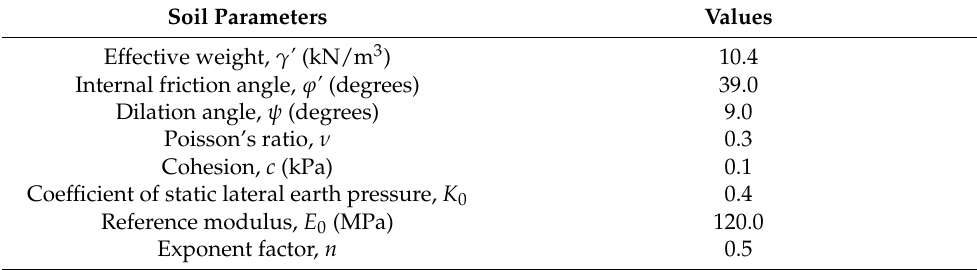
Figure 3. Three-dimensional pile ‒ soil model in ABAQUS. Table 1. Parameters of the pile used in the ABAQUS model. Table 2. Parameters of the soil used in